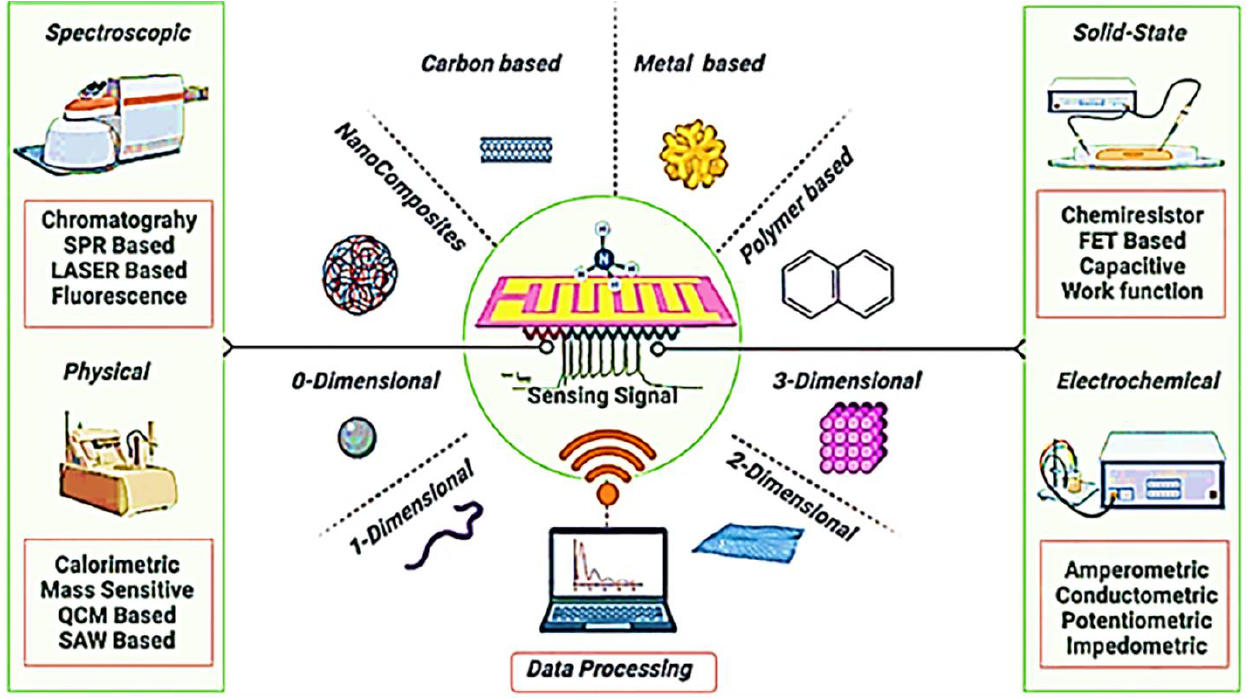
Figure 6. Schematic of various air contaminant sensing strategies depending upon nature of trans- ducing signals and diversified sensing materials with different dimensions for air monitoring and detection [160]. Reproduced with permission from Wiley.